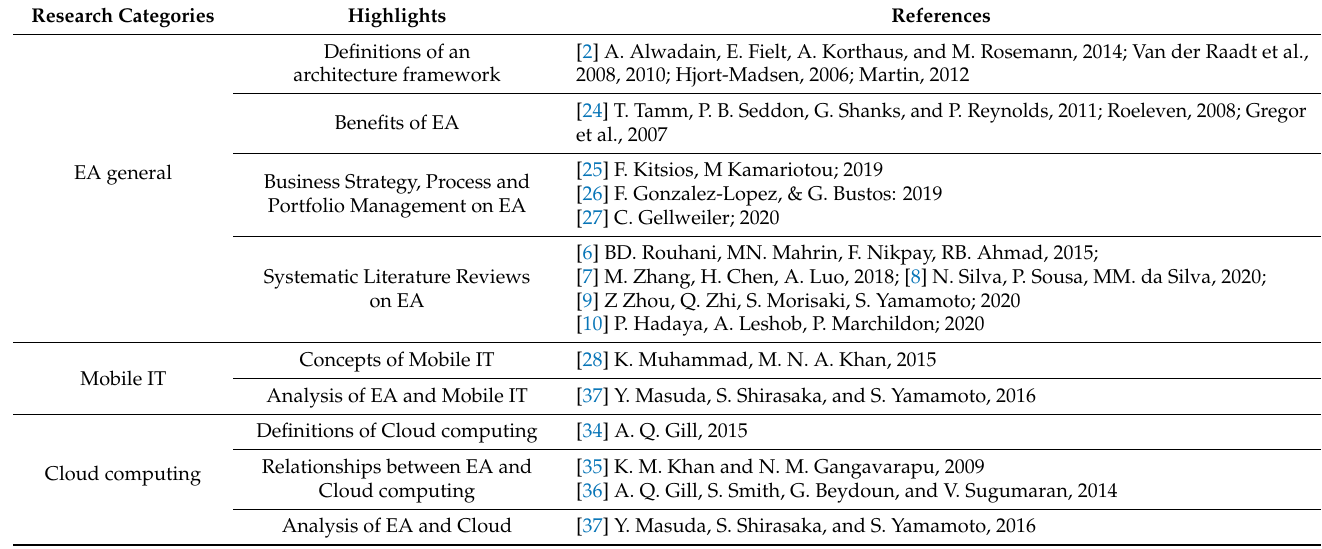
Table 1. Overview of literature review for EA and digital IT.